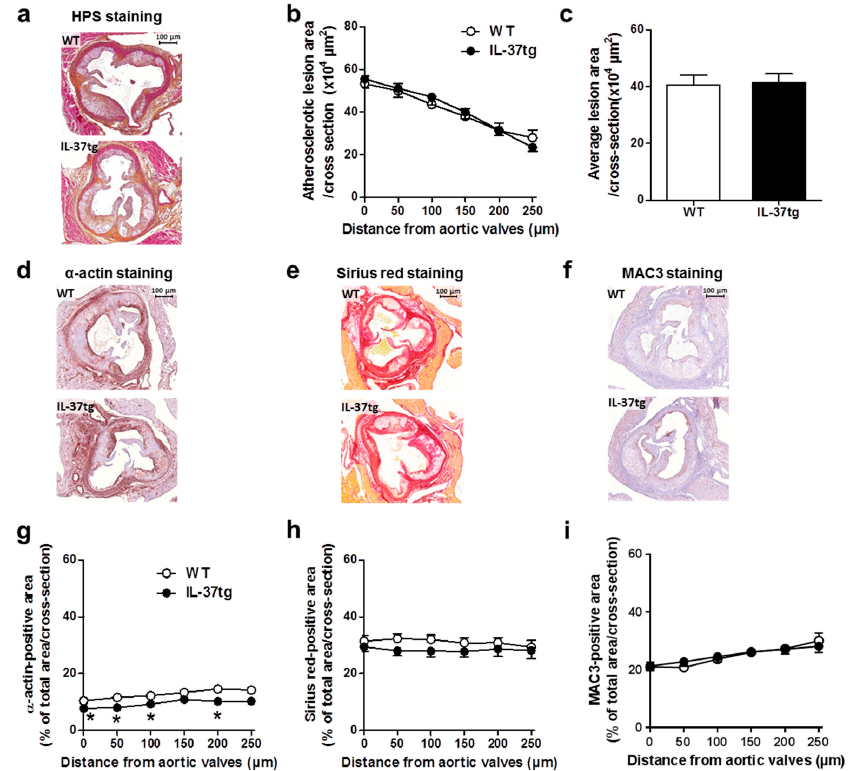
Figure 4. Expression of IL-37 in hematopoietic cells does not affect atherosclerotic lesion development and macrophage content. At the end of the study, after eight weeks of Western-type diet (WTD)-feeding, Ldlr ⁻ / ⁻ mice transplanted with either IL-37tg or wild-type (WT) bone marrow were killed and slides of the valve area of the aortic root were stained with hematoxylin-phloxine-saffron (HPS) and representative pictures are shown ( a ); (scale bar represents 100 μ m.) Lesion area as a function of distance in the aortic root was determined by calculating the lesion area of six consecutive cross-sections starting from the appearance of open aortic valve leaflets ( b ); The average total lesion area of these six cross-sections per mouse was calculated ( c ); Representative pictures of α -actin staining ( d ); Sirius red staining ( e ); and MAC3 (a macrophage-specific antigen) staining ( f ) are presented. The α -actin-positive smooth muscle cell content ( g ); Sirius red-positive collagen content ( h ); and MAC3-positive macrophage content ( i ) were determined. Values are means ± SEM; n = 15 per group; * p < 0.05.